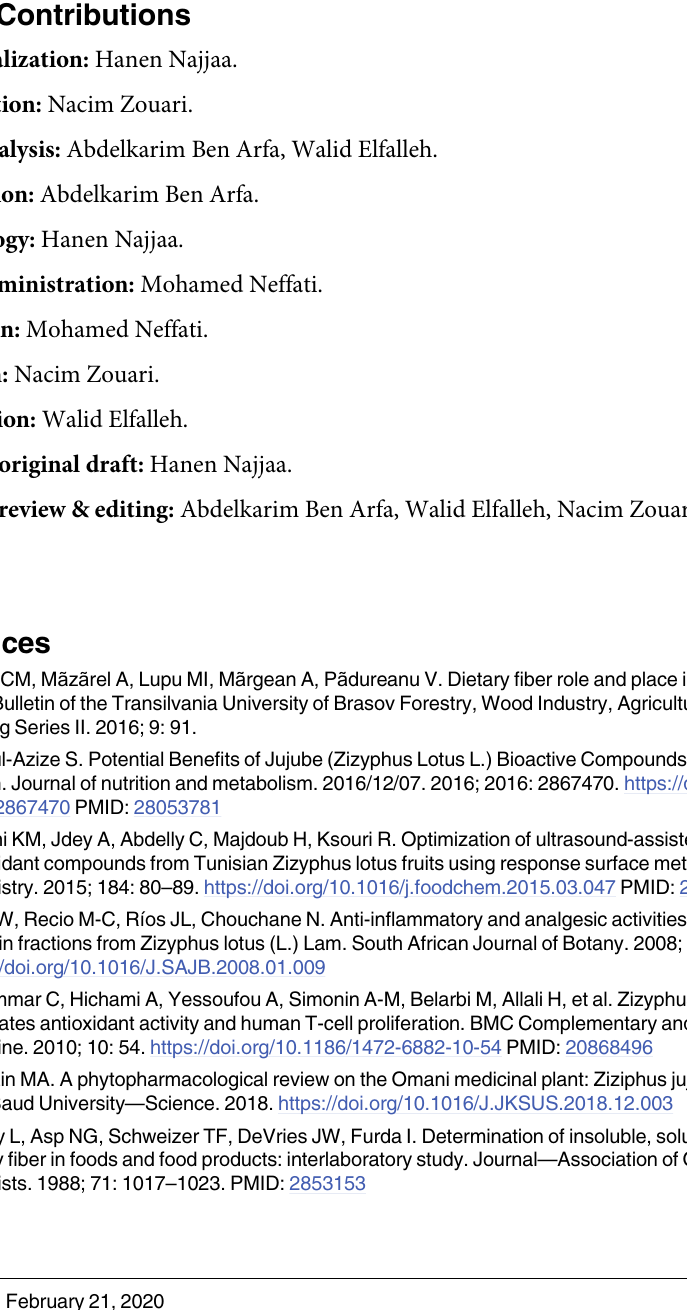
S1 Fig. Graphical abstract. S1 Table. All raw data are available in the supplementary (xls)